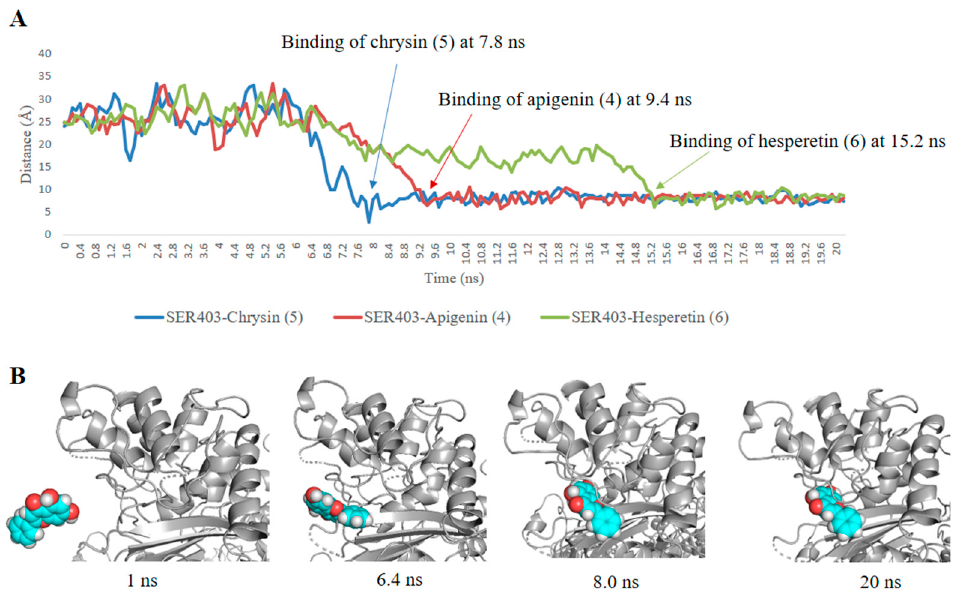
Figure 4. Binding process of compounds (4–6). ( A ) Distance changes between the C α atom of residue SER-403 (i.e., the catalytic residue inside PBP2a active site) and compounds 4–6. ( B ) Snapshots of PBP2a system during the binding process with chrysin (5).